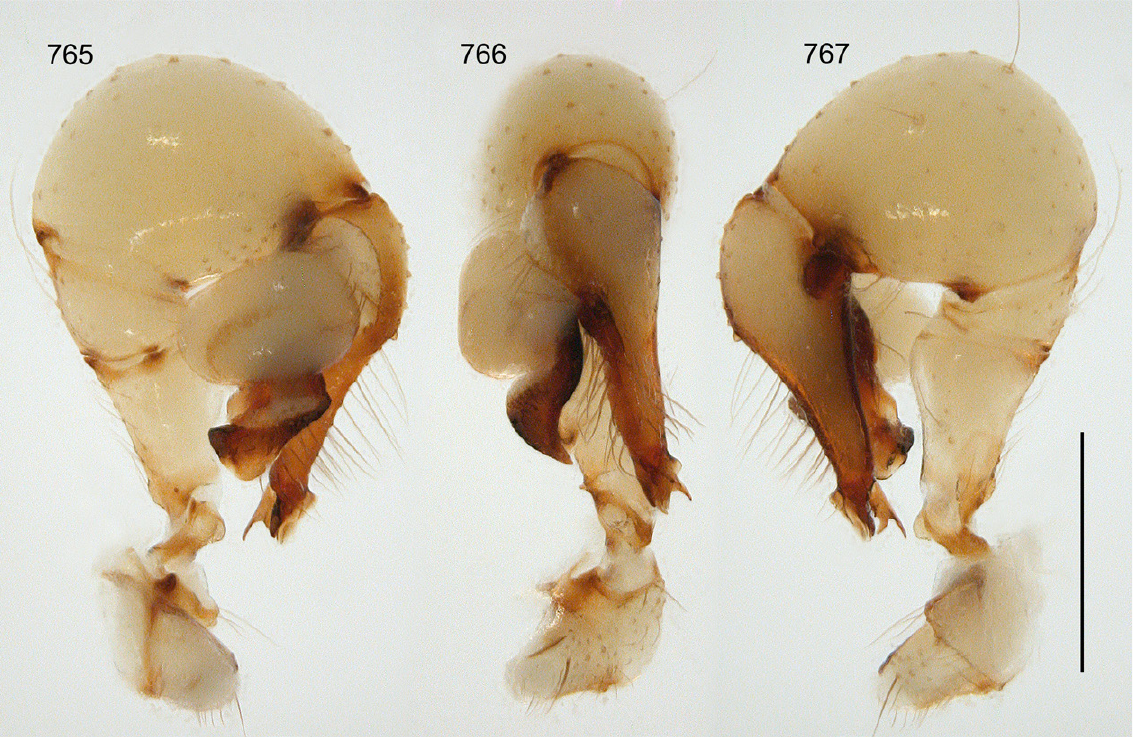
Figs 765–767. Crossopriza sengleti sp. nov.; non-type male from Iran, Fars, Seridjan (MHNG); left palp, prolateral, dorsal, and retrolateral views. Scale bar = 0.5